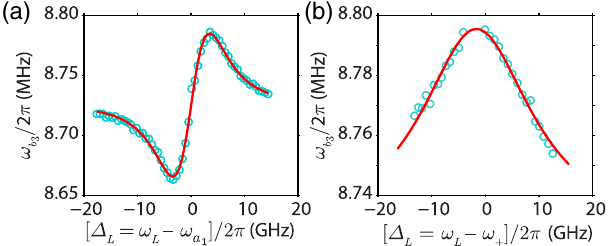
FIG. 7. (a) Dynamic optical spring effect measured by exciting the upper frequency supermode resonance far from the anticross- ¼ 10 μ W, κ = 2 π ¼ ing point ( ∼ a 2 mode) ( V 1 ¼ V 2 ¼ 1 V, P in 12 . 5 GHz, Δ T ≈ 10% ). (b) Static optical spring shift of the b 3 resonance frequency versus laser detuning Δ from the upper L ( ∼ a þ ) supermode resonance near the anticrossing point ( V 1 ¼ 10 . 8 V, V ¼ 1 V, P ¼ 50 μ W, κ = 2 π ¼ 26 GHz, Δ T ≈ 25% ). 2 in In both (a) and (b) V 2 is fixed at 1 V [see Fig. 4(a)] and the measured data (circles) correspond to a Lorentzian fit to the resonance frequency of the optically transduced thermal noise peak at ω . In (a) the red curve is a fit to the data using a b 3 dynamical optical spring model [38] with linear optomechanical = 2 π ¼ 1 . 72 MHz. In (b) the red curve coupling coefficient ~ g a 2 ;b 3 is a fit to the data using a static spring model [cf. Eqs. (8) and (9)] = 2 π ¼ 46 Hz. In both the spring with x 2 -coupling coefficient ~ g 0 b 3 models of (a) and (b) the intracavity photon number versus Þ is calibrated from the known input laser power, detuning n ð Δ L cavity linewidth, and on-resonance transmission